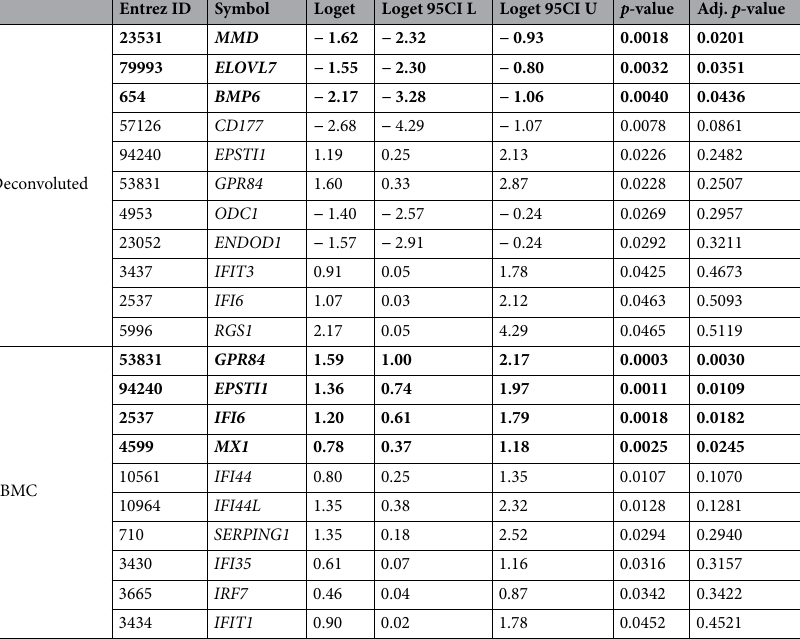
Table 2. Confirmation of candidate genes previously associated with anti-TNF response using RNA-seq analysis. Loget